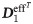
Results of training SDPC on the natural images (left column) and on the face database (right column) with a feedback strength kFB = 1.(A): Randomly selected input images from the natural images database (denoted x in the text). The two databases are pre-processed with Local Contrast Normalization [40] and whitening. (B) & (F): 16 randomly selected first-layer Receptive Fields (RFs) from the 64 RFs composing D1effT (note that D1effT=D1T, see Eq 3). The RFs are ranked by their activation probability in a descending order. The RF size of neurons located on the first layer is 9 × 9 px for both databases. (C): Reconstruction of images corresponding to the input images shown in (A) from the representation in the first layer, denoted γ1eff (note that γ1eff=D1Tγ1, see Eq 18). (D) & (G): 32 sub-sampled RFs out of 128 RFs composing D2effT (note that D2effT=D1TD2T, see Eq 3), ranked by their activation probability in descending order. The size of the RF from neurons located on the second layer is 22 × 22 px on the natural images database (D) and 33 × 33 px on the face database (G). (E): Reconstruction of images corresponding to the input images shown in (A) from the representation in the second layer, denoted γ2eff (note that γ2eff=D1TD2Tγ2, see Eq 18).